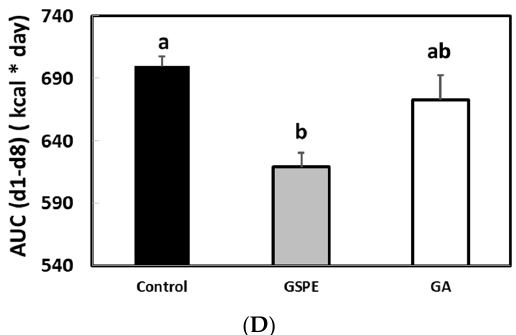
Figure 3. Antagonism of Exendin (9 ‐ 39) on the effects of grape seed proanthocyanidin extract (GSPE) and gallic acid on food intake. ( A , B ) Wistar rats received one acute oral GSPE or i.p. Glucagon ‐ like peptide ‐ 1 (GLP ‐ 1) treatment, with or without Exendin (9 ‐ 39) prior to the start of the food intake period. Food intake was measured at the time intervals indicated, counted from the initiation of the dark phase. The black column refers to the control group: ( A ) the white column refers to GSPE treatment of 0.5 g/kg body weight (BW); the grey column indicates those animals that previously received treatment with Exendin (9 ‐ 39); ( B ) food intake measurements were at 3 h after the food initiation period. n = 14 per group. # p < 0.05 vs. antagonist. * p < 0.05 vs. control group. Different superscripts indicate statistical differences between the treatments by t ‐ test; ( C , D ) relate to the effects of gallic acid on food intake: ( C ) animals received one dose of treatment. The white column refers to gallic acid treatment; the grey column indicated those animals that previously received treatment with Exendin (9 ‐ 39); ( D ) refers to animals treated for eight days with the indicated treatments. n = 9 per group * p < 0.05 vs. control group by t ‐ test. Different superscripts (lowercase in panels B and D) indicate statistical differences between the treatments.